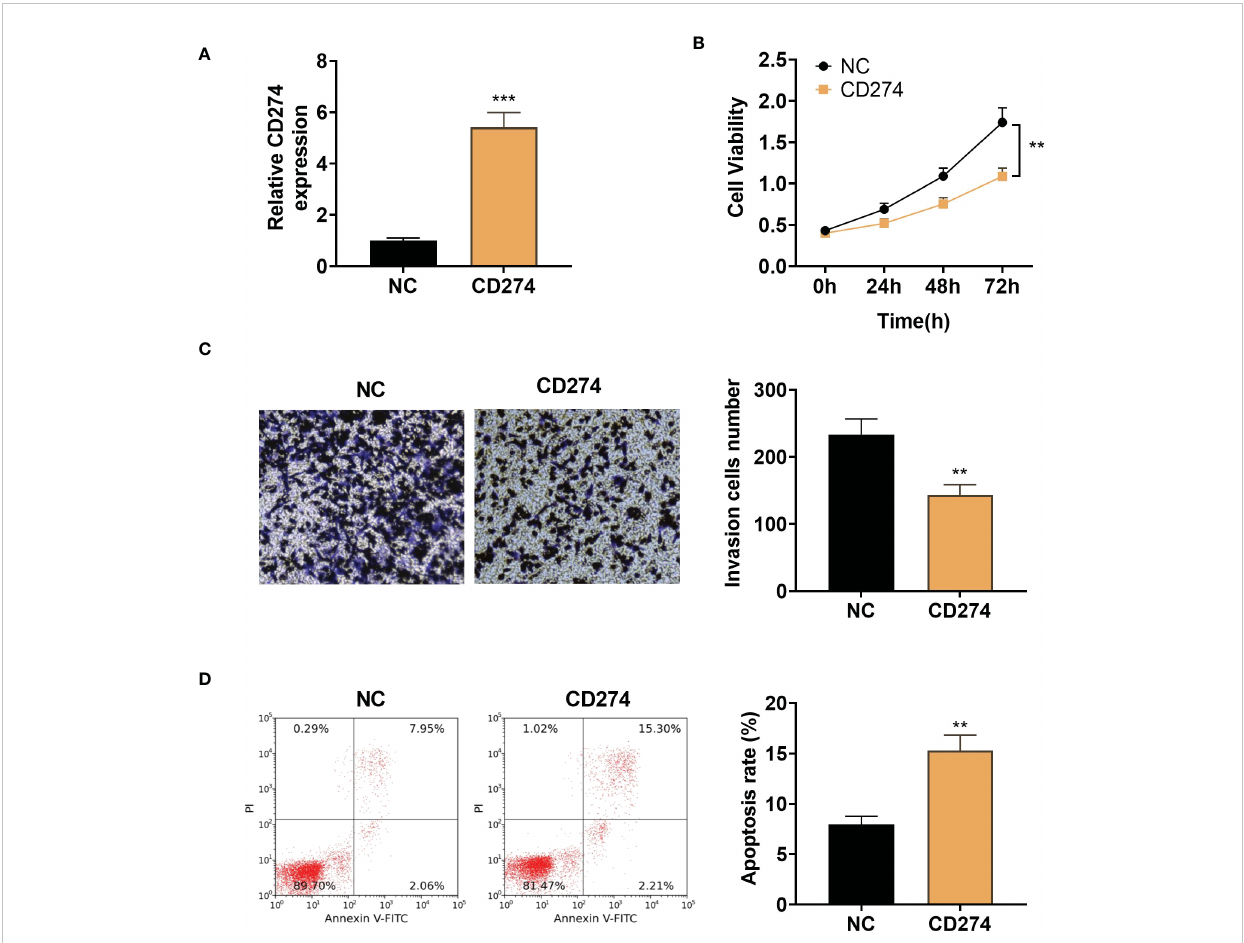
FIGURE 8 Up-regulation of CD274 inhibits proliferation and invasion and increases apoptosis in A549 cells (A) : qRT-PCR assay of CD274 expression in A549 cells. (B) : CCK8 assay of A549 cell proliferation. (C) : Transwell assay of A549 cell invasion. (D) : Flow cytometry detection of apoptosis in A549